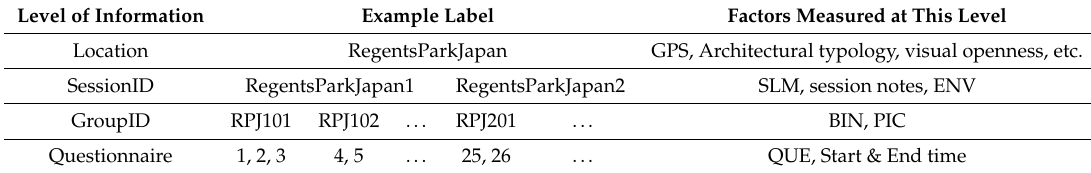
Table 1. Labeling system for on site data collection. Regent’s Park Japanese Garden is used as an example location. SLM: Sound Level Meter (acoustical factors); ENV: Environmental factors;